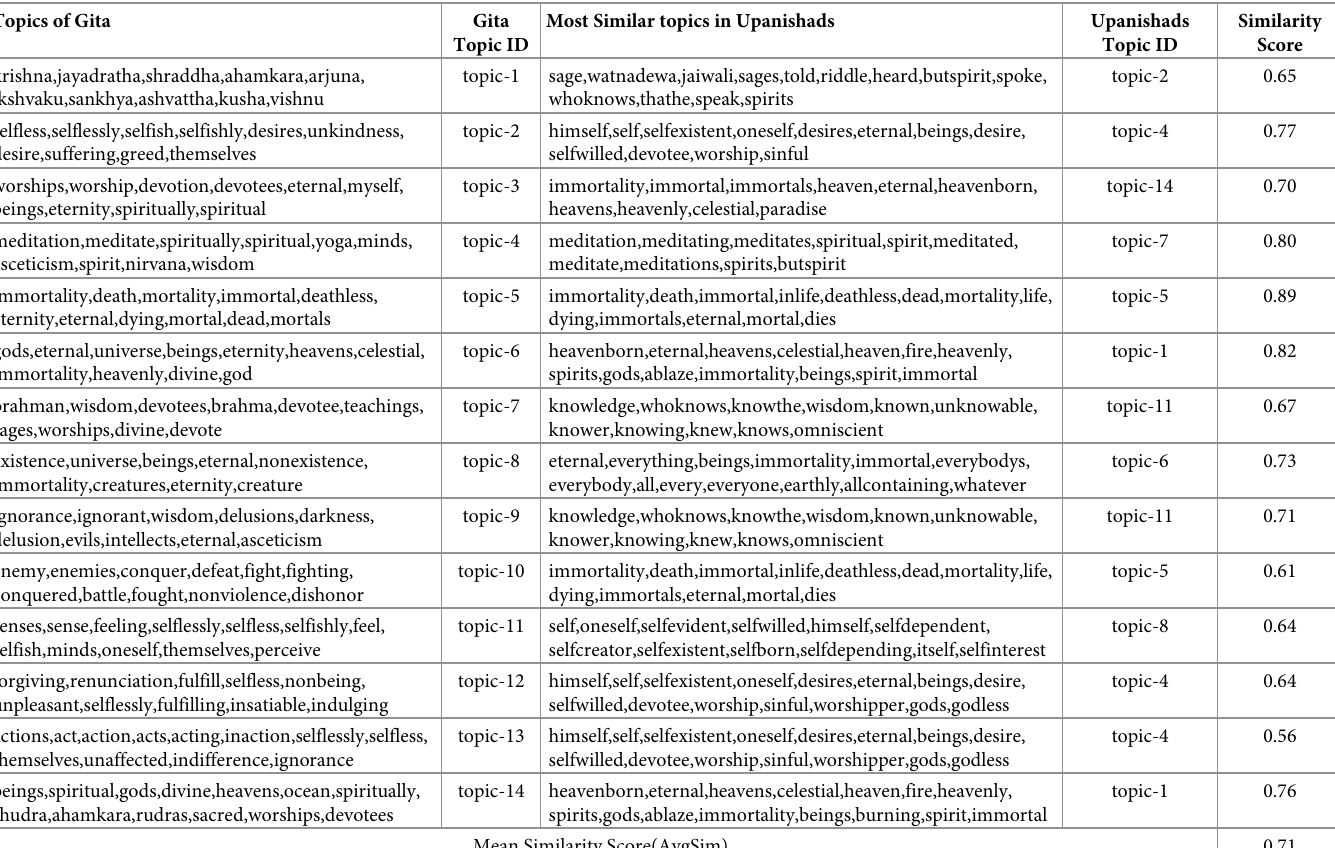
Table 6. Topics of the Bhagavad Gita(Eknath Easwaran) with most similar topics from the Ten Principal Upanishads(Shri Purohit Swami & W.B. Yeats). Topics of